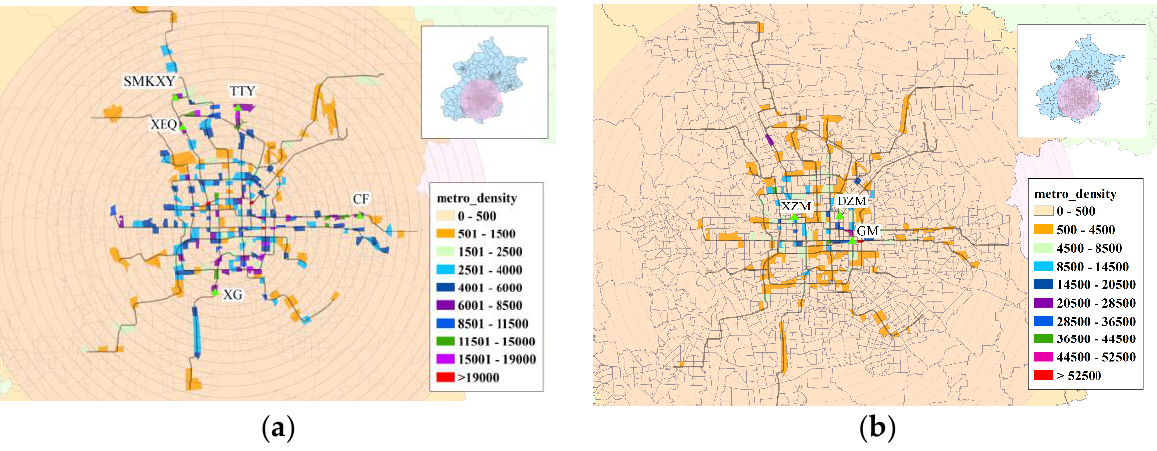
Figure 15. The density distribution of metro passengers (morning peak): (a) origin and ( b ) destina- tion.